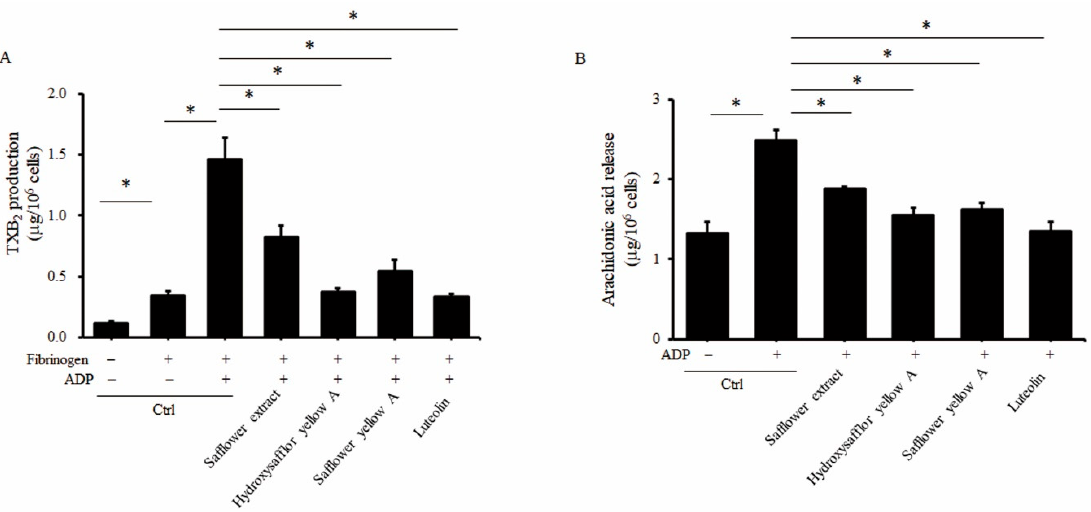
Figure 5. Effects of safflower extract on the production of TXB 2 and AA in human platelets. PRP was treated with safflower extract or compounds found in safflower extract for 1 h. Isolated platelets were collected and then stimulated with 3 μ M fibrinogen and 10 μ M ADP at 37 °C. The content of TXB2 ( A ) or AA ( B ) was determined by enzyme immunoassay. * p < 0.05 between two groups.